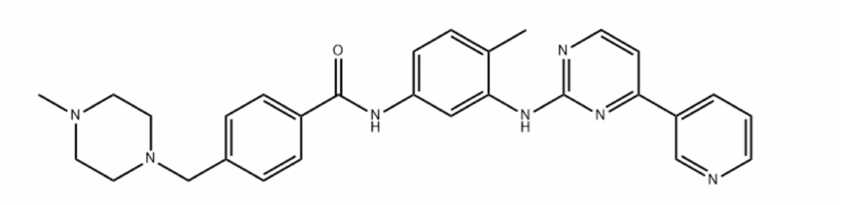
Figure 1. Chemical structure of